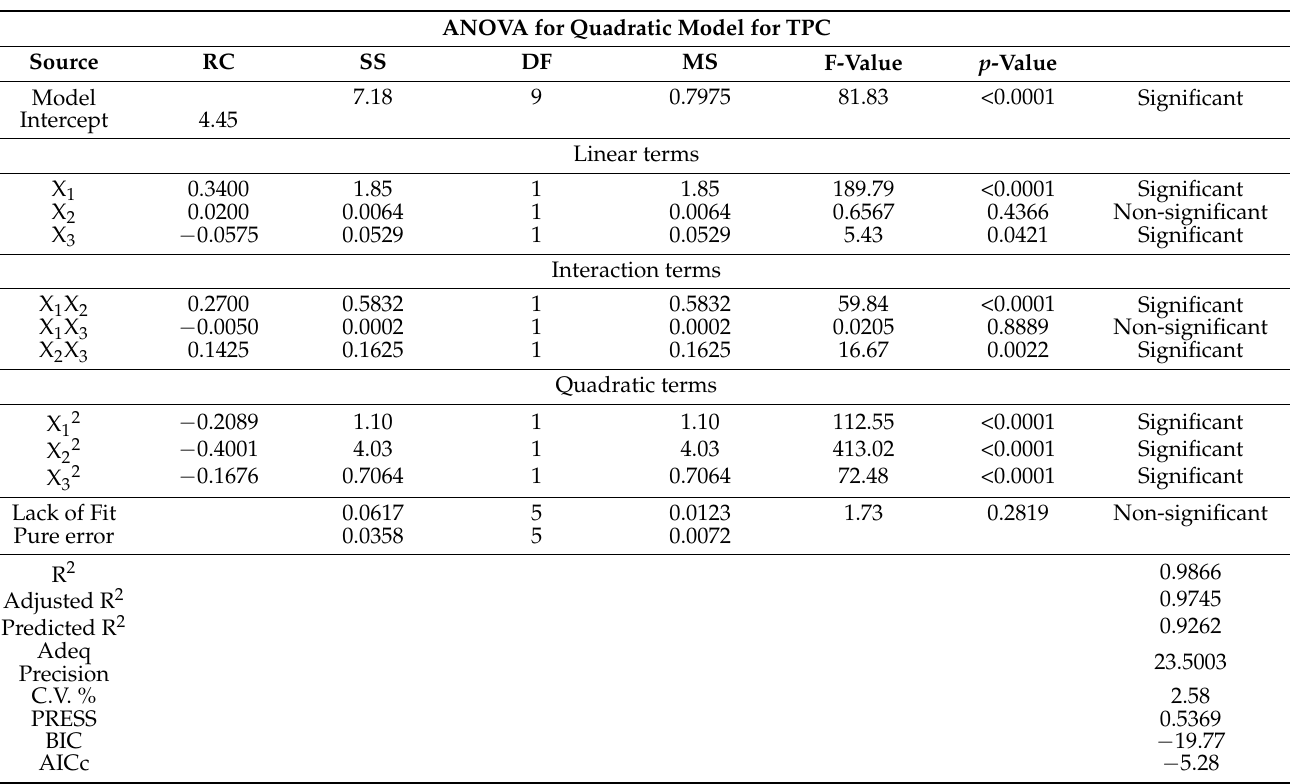
Table 2. ANOVA for quadratic model (transfer function: none). ANOVA for Quadratic Model for